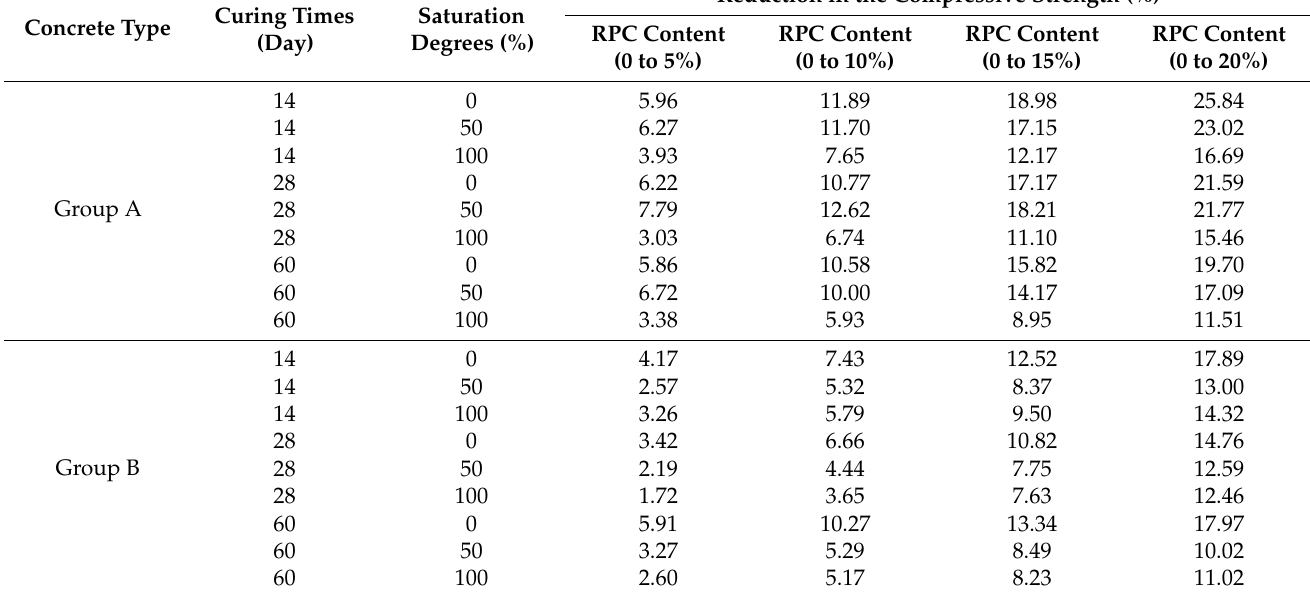
Table 6. Compressive strength reduction rate of LCC samples at various curing times and saturation degrees with increasing RPCs